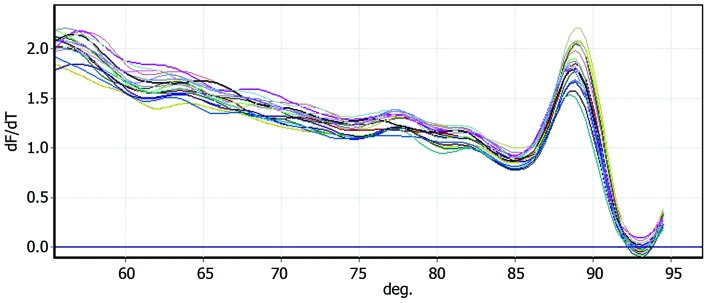
Melting curve of cDNA from HepG2, Huh7, SMMC7721, Bel-7402 and HL-7702 cells (23 copies demonstrating reliability).